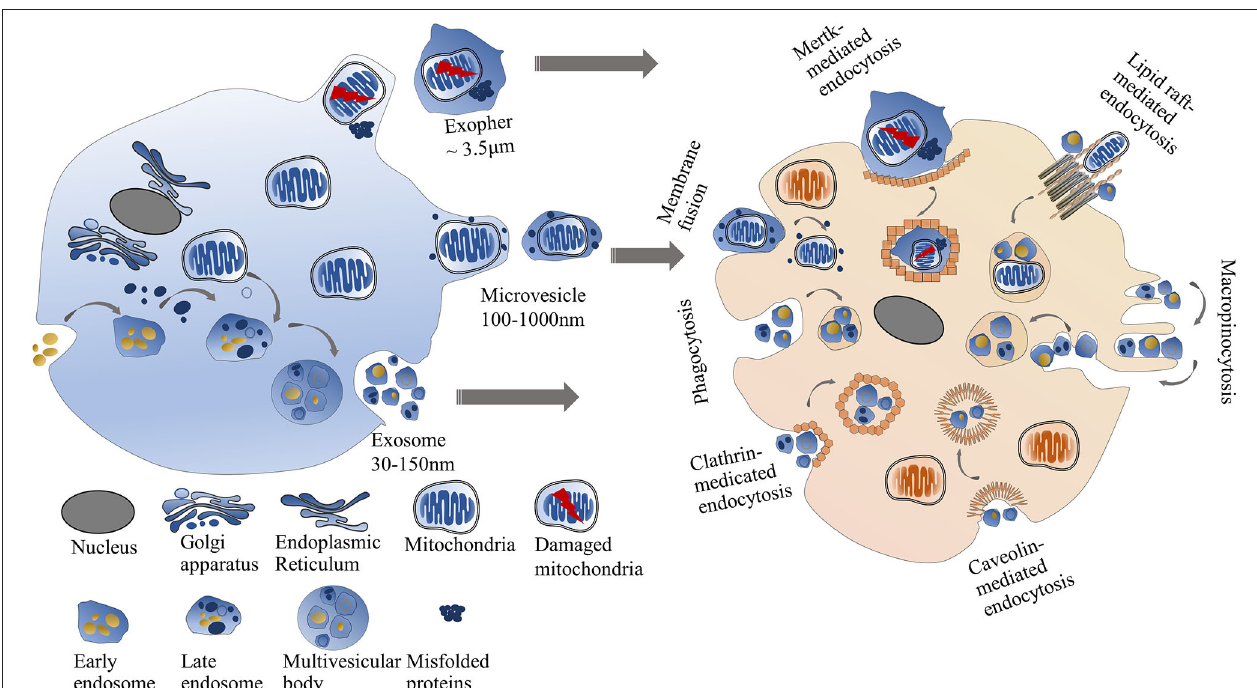
FIGURE 2 | Mitochondrial transfer via EVs. The intercellular mitochondrial transfer can be mediated through EVs including exosomes, microvesicles, and exophers. Exosomes are smaller than microvesicles. Exophers are large membrane-surrounded microparticles usually containing damaged mitochondria and misfolded proteins. Exosomes or microvesicles can directly fuse with the recipient cell membrane or be engulfed by recipient cells through multiple pathways, including clathrin-dependent endocytosis, caveolin-mediated endocytosis, lipid raft-mediated endocytosis, phagocytosis, and micropinocytosis. Cardiac exophers can internalized into recipient cells via Mertk-mediated endocytosis.